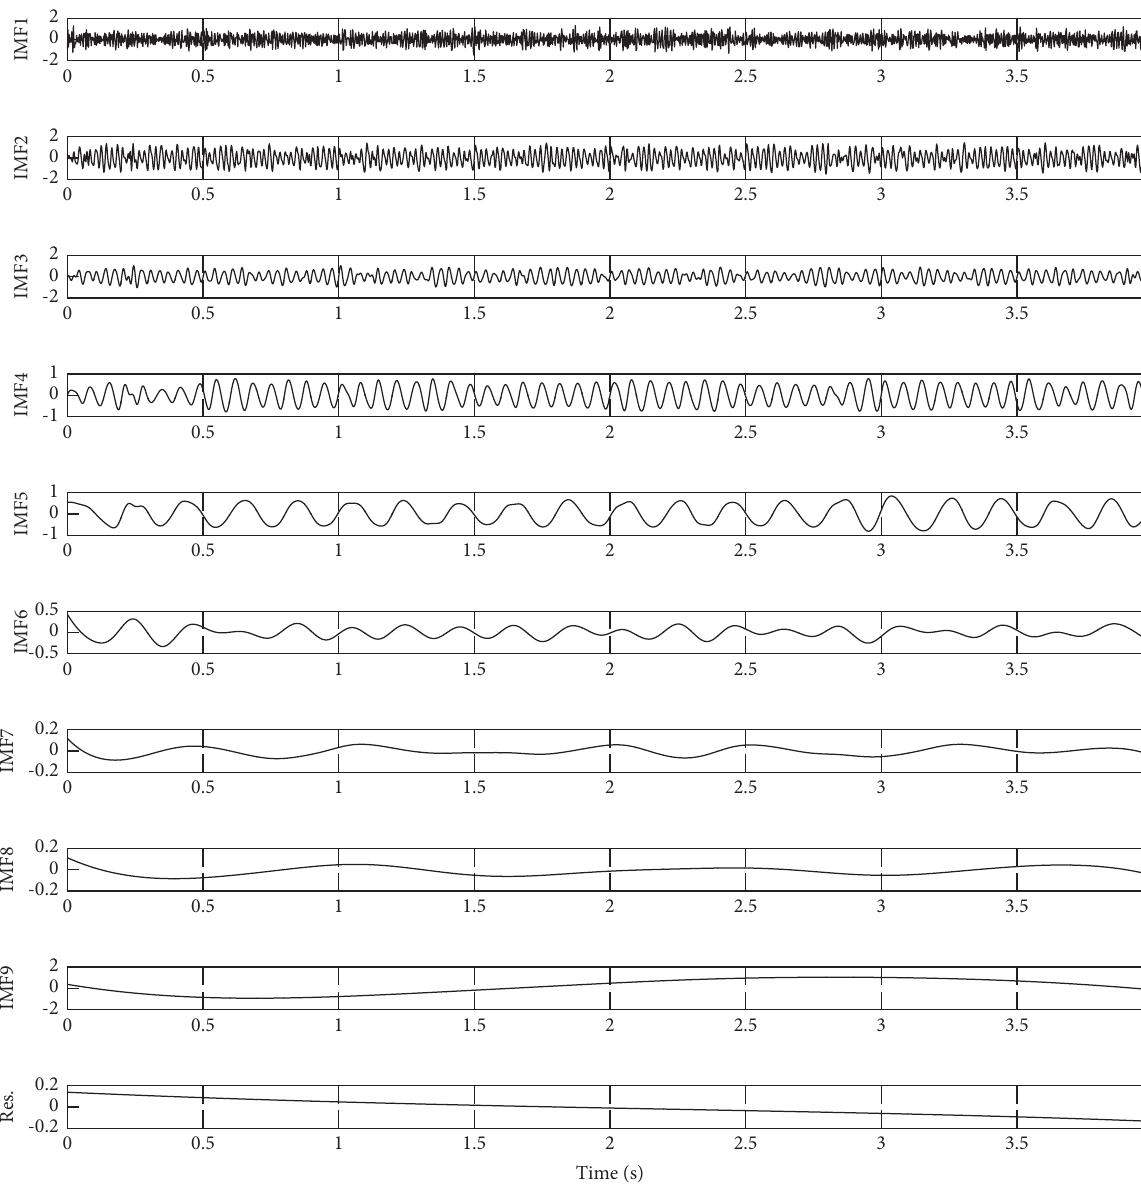
Figure 5: Waveforms of IMF components and residual